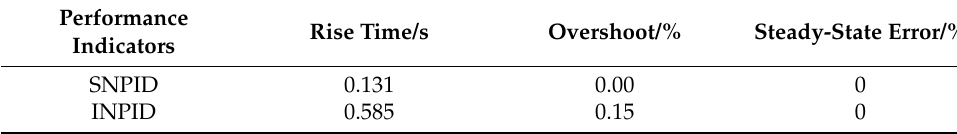
Table 5. Key performance indicators of the step